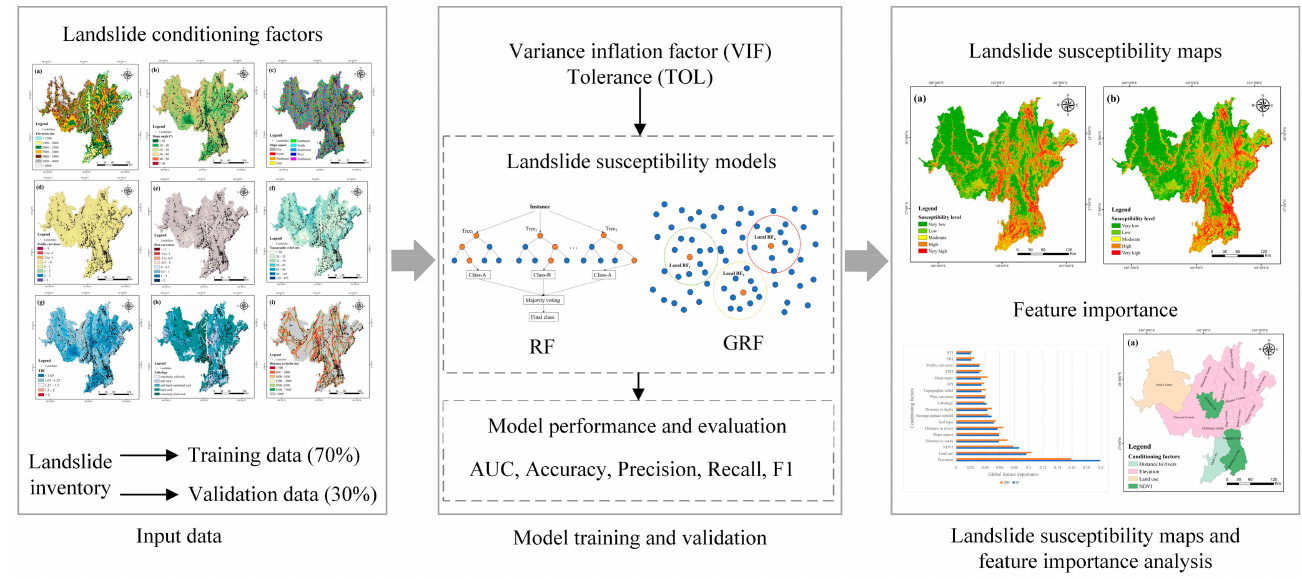
Figure 3. An overview of the